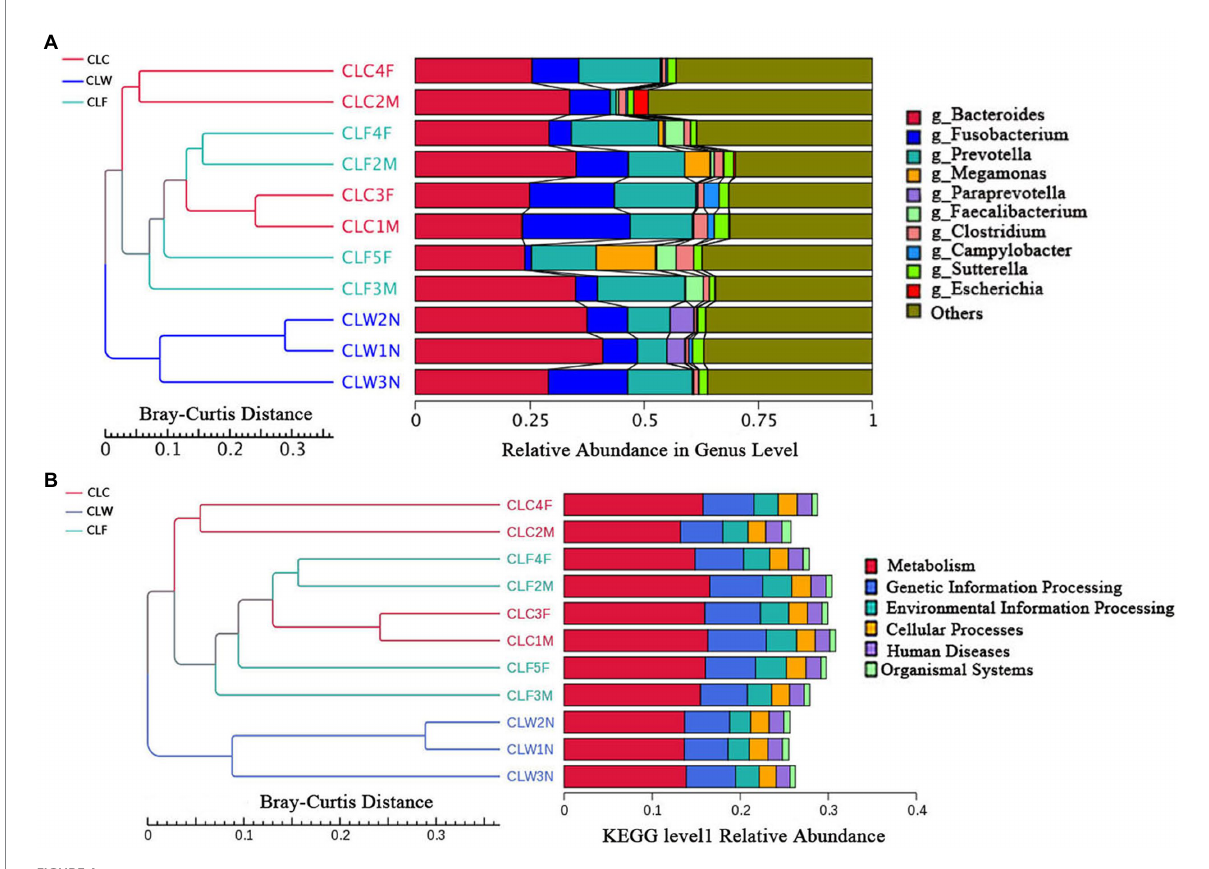
FIGURE 4 Clustering tree based on Bray-Curtis distance and annotated species abundance at genus level (A) , and annotation function abundance at KEGG level 1 (B)